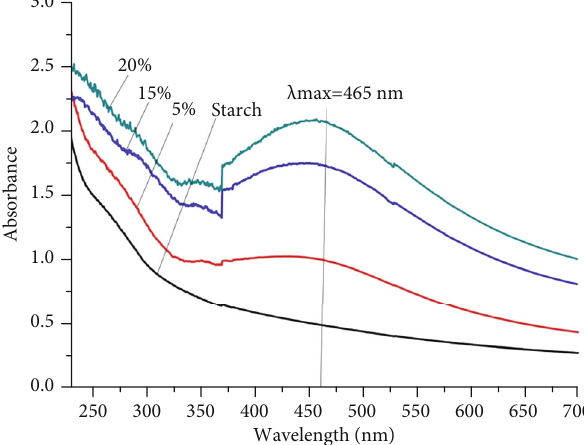
Figure 4: In fl uence of AgNP solution on UV resistance capacity of the fi